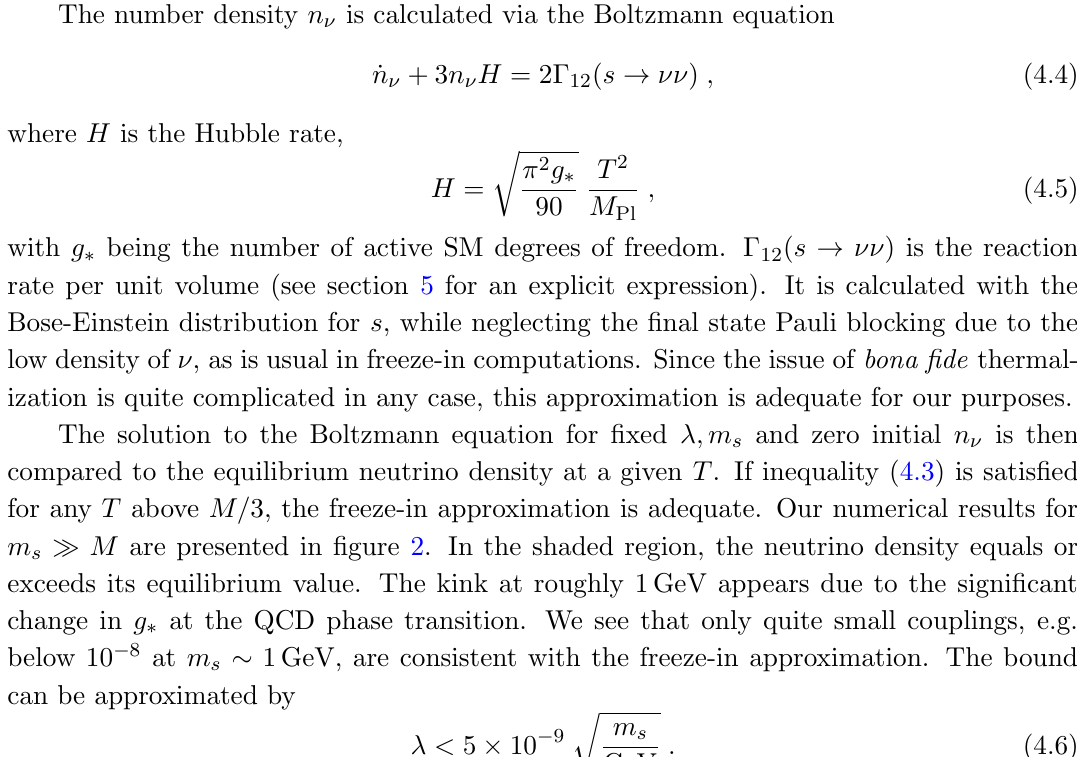
such that the reverse (cid:23)